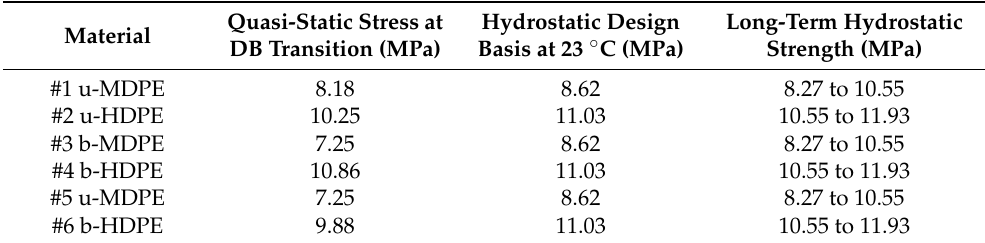
Figure 8. Residual stress distribution along the wall thickness for the six PE pipes. Table 3. The time-independent quasi-static stress from Ref. [16] and the hydrostatic design basis (HDB) based on the long-term hydrostatic strength for the six PE pipes